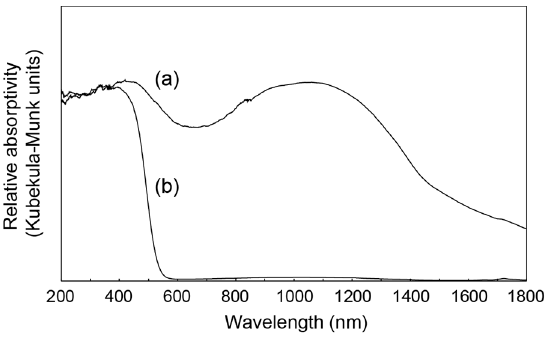
Figure 7. Diffuse reflectance UV-vis spectra of C 12 pda-V 10 hybrids: ( a ) dark green C 12 pda-V 10 hybrids synthesized at pH 6.0; ( b ) yellow C 12 pda-V 10 hybrids synthesized at pH 4.0.